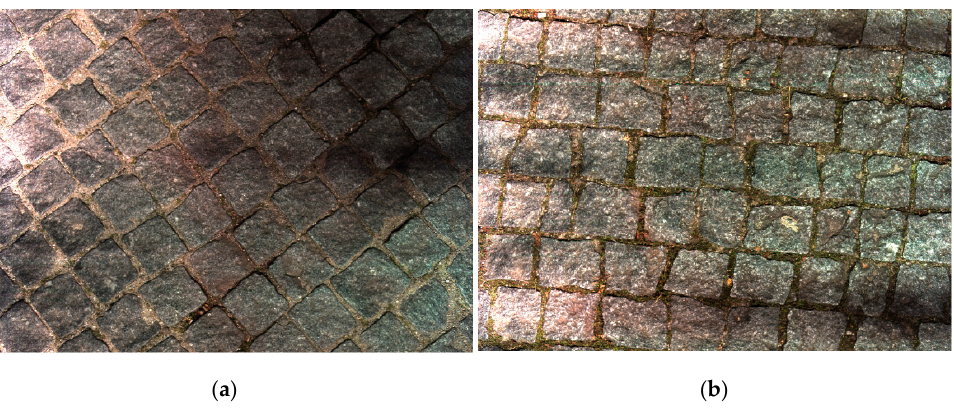
Figure 6. Scanning results in different situations: ( a ) Sunny daylight time; ( b ) At night.